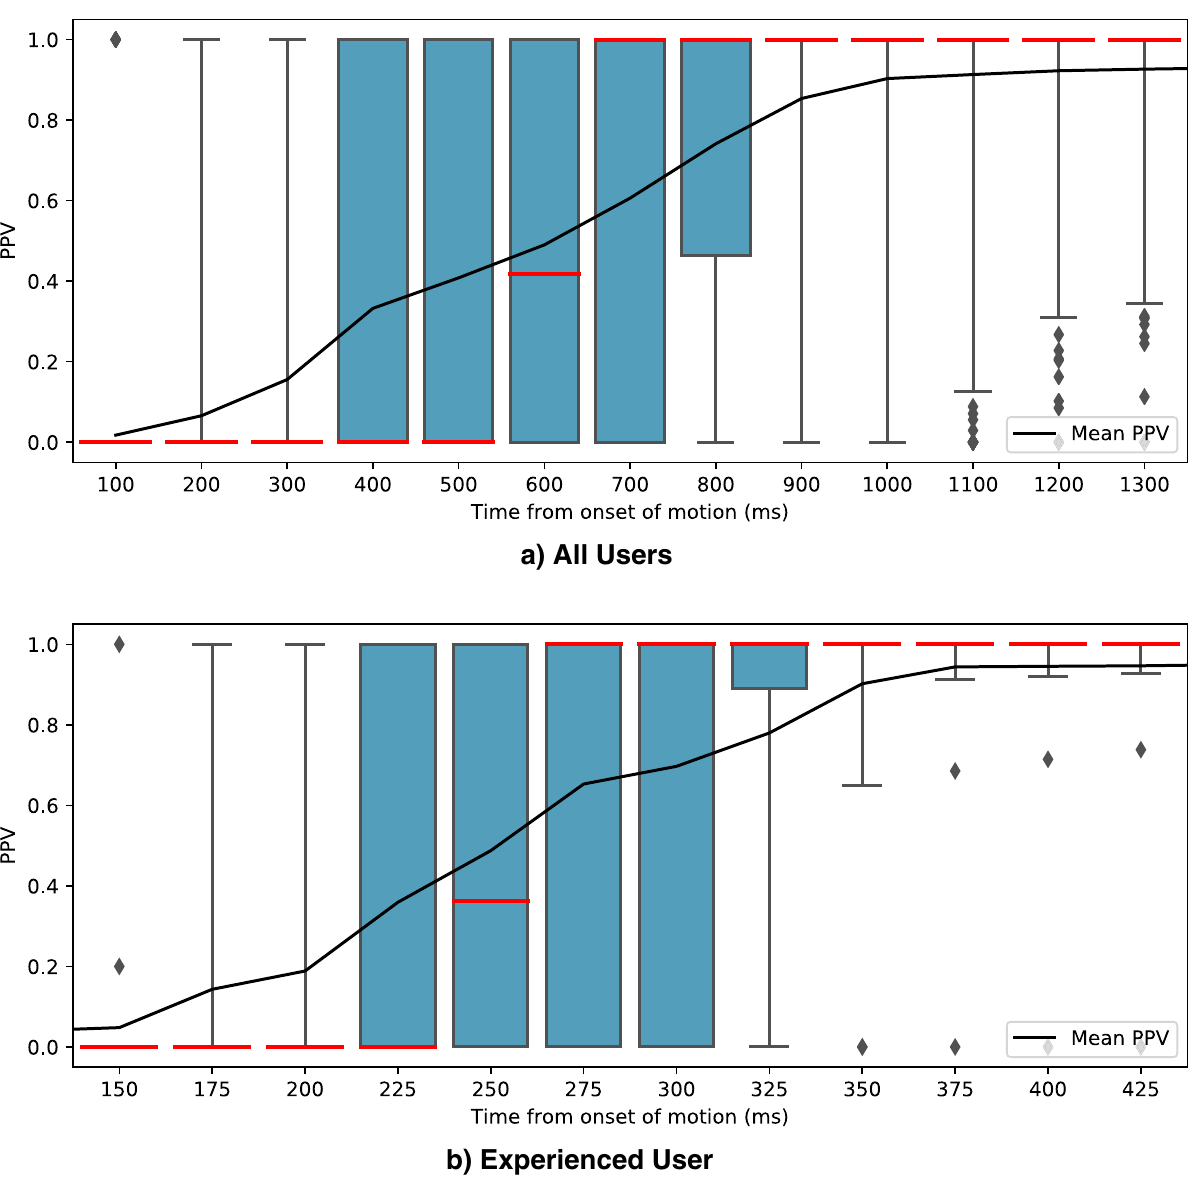
Figure 8. Positive predictive value (PPV) through gesture transitions. ( a ) Box plot representation of the PPV results from all trials of all users measured for different periods of time elapsed since onset of motion. ( b ) Box plot representation of the PPV results from all trials of an experienced user (user 3) measured for different periods of time elapsed since onset of motion. The whiskers of the box plots have been set to the 5th and 95th percentiles. The mean PPV is overlaid on top of the box